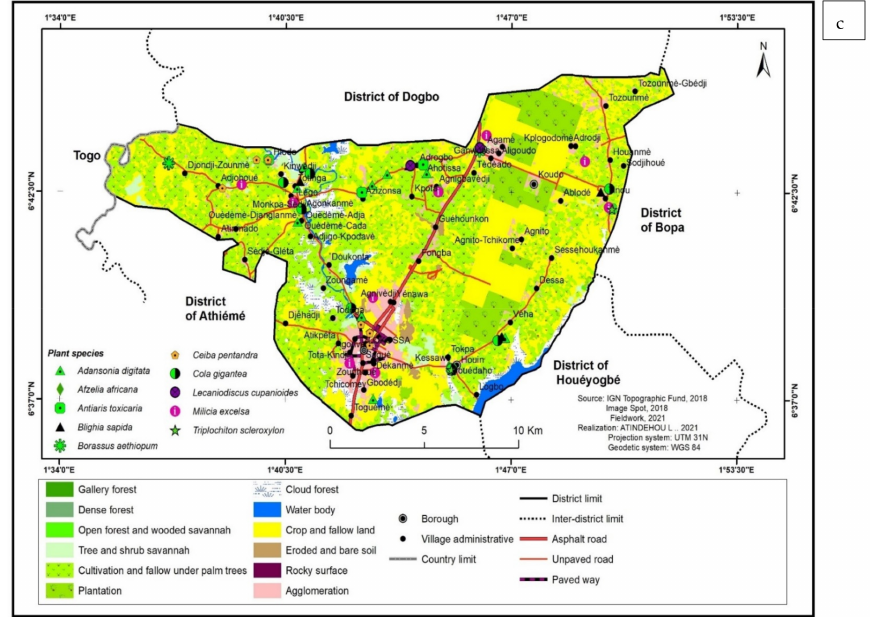
Figure 5. LOT species inventoried and geolocated on the land cover map of each study area.